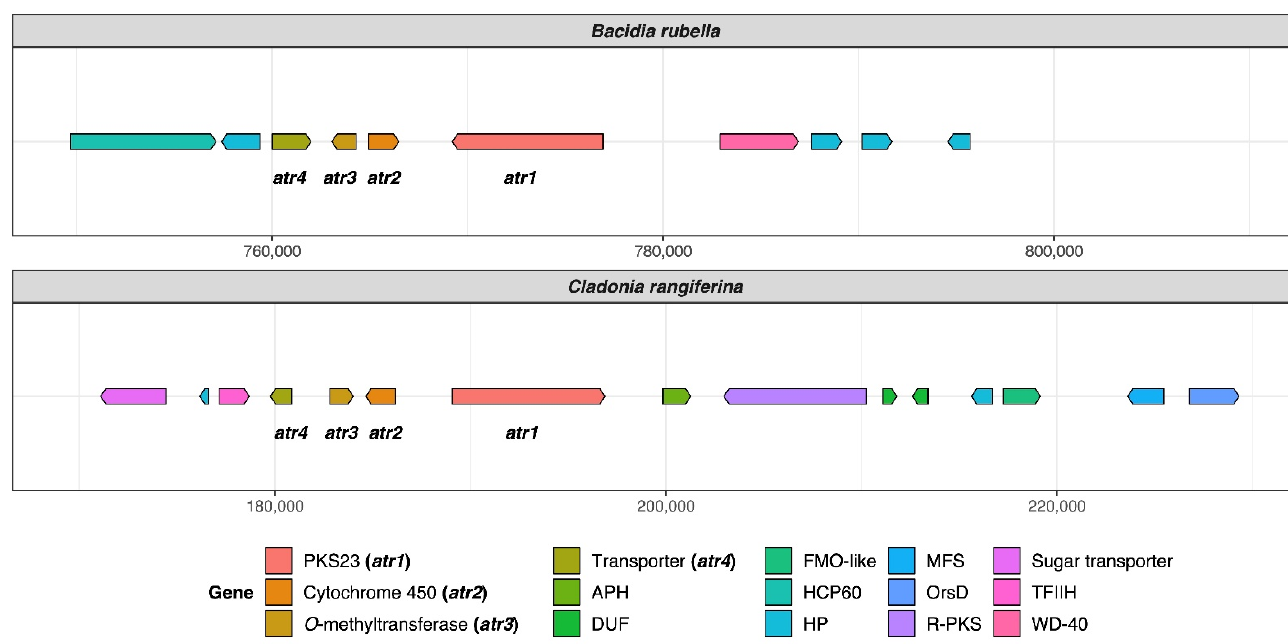
Figure 2. Organization of putative atranorin BGCs in Bacidia rubella and Cladonia rangiferina . The genes PKS23 ( atr1 ), Cytochrome 450 ( atr2 ), O -methyltransferase ( atr3 ), and transporter gene ( atr4 ) are present on the left side of the gene arrow plot. The BLAST percent similarity between two genes is 73% for atr1 , 74% for atr2 , 78% for atr3 , and 91.5% for atr4 . APH, phosphotransferase enzyme family (PF01636); DUF, domain of unknown function; FMO-like, flavin-containing monooxygenase family (PF00743); HCP60, HSP60 chaperone family (PF00118); HP, hypothetical protein; MFS, Major Facilitator Superfamily, transporter gene (PF07690); R-PKS, reducing PKS (in this case from R-VIII group); OrsD, Orsellinic acid/F9775 biosynthesis cluster protein D family (PF12013); TFIIH, Ssl1-like protein, subunit of the transcription factor II H complex (PF04056); Sugar_tr, Sugar transporter family (PF00083); WD-40, WD40 repeat (PF00400).